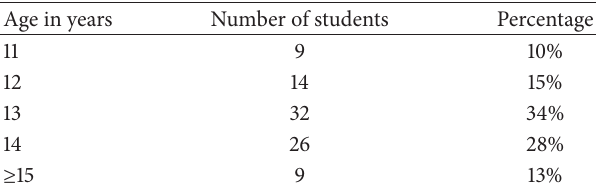
Table 2: Exposure to probable trigger factor among students.